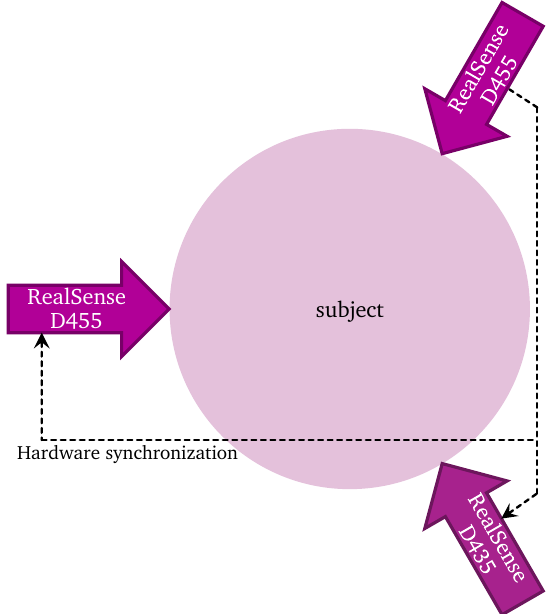
Figure 4. Physical setup of the experiment.